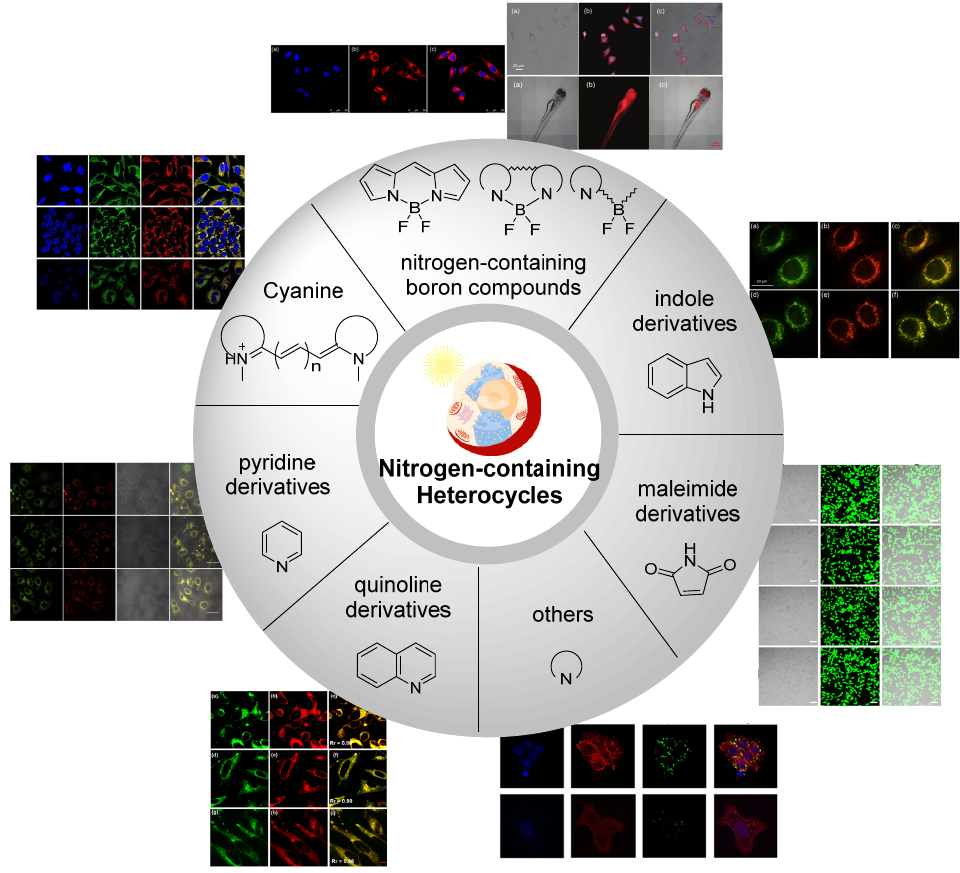
Figure 1. N -heterocyclic small molecules for synthesis and applications in direct fluorescence cell imaging. cell